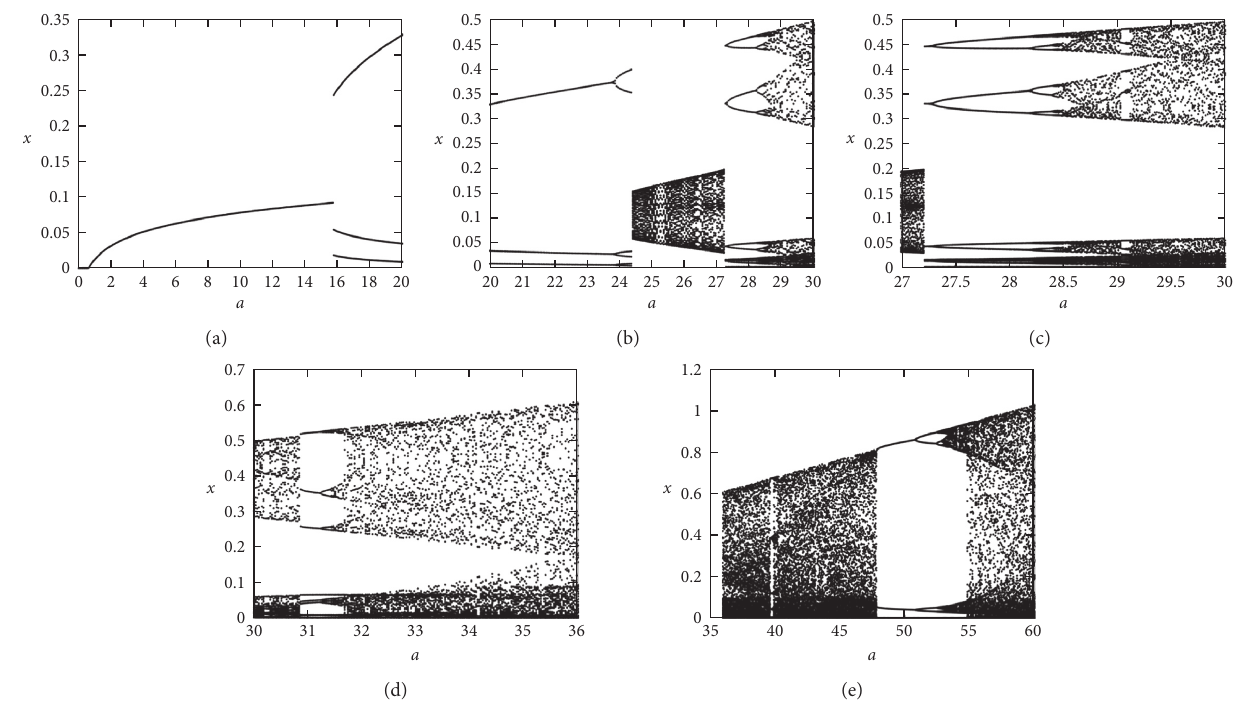
Figure 2: Magnification of part of Figure